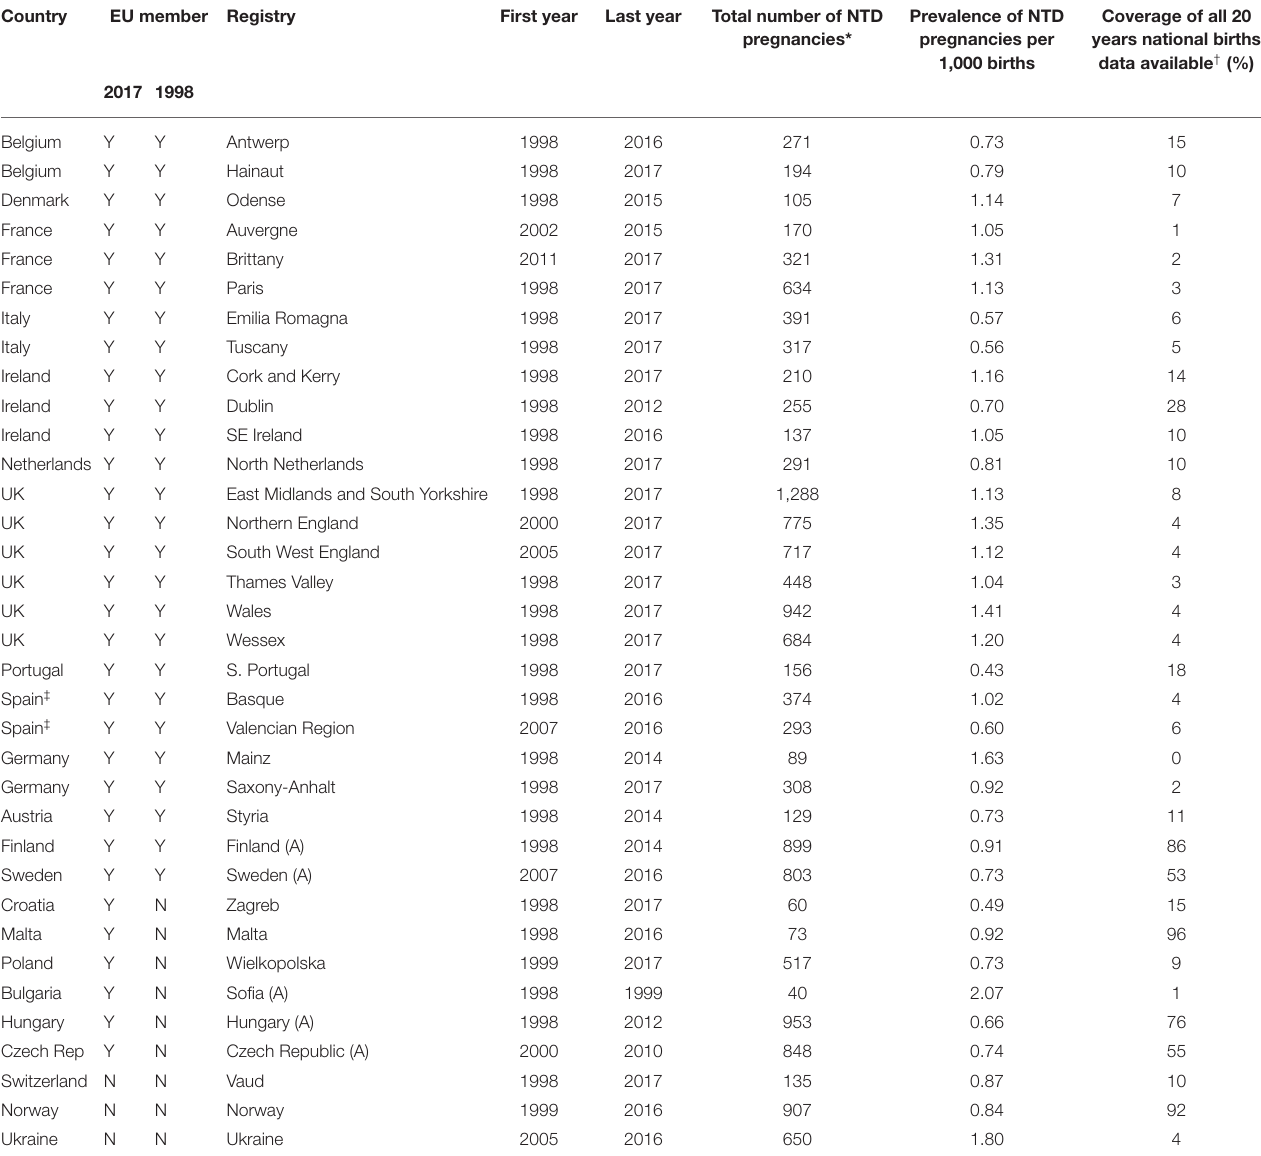
TABLE 1 | Number and prevalence of neural tube defect (NTD) pregnancies in EUROCAT registries reported from 1998 to 2017 and the proportion of the population covered over the whole 20 year period.